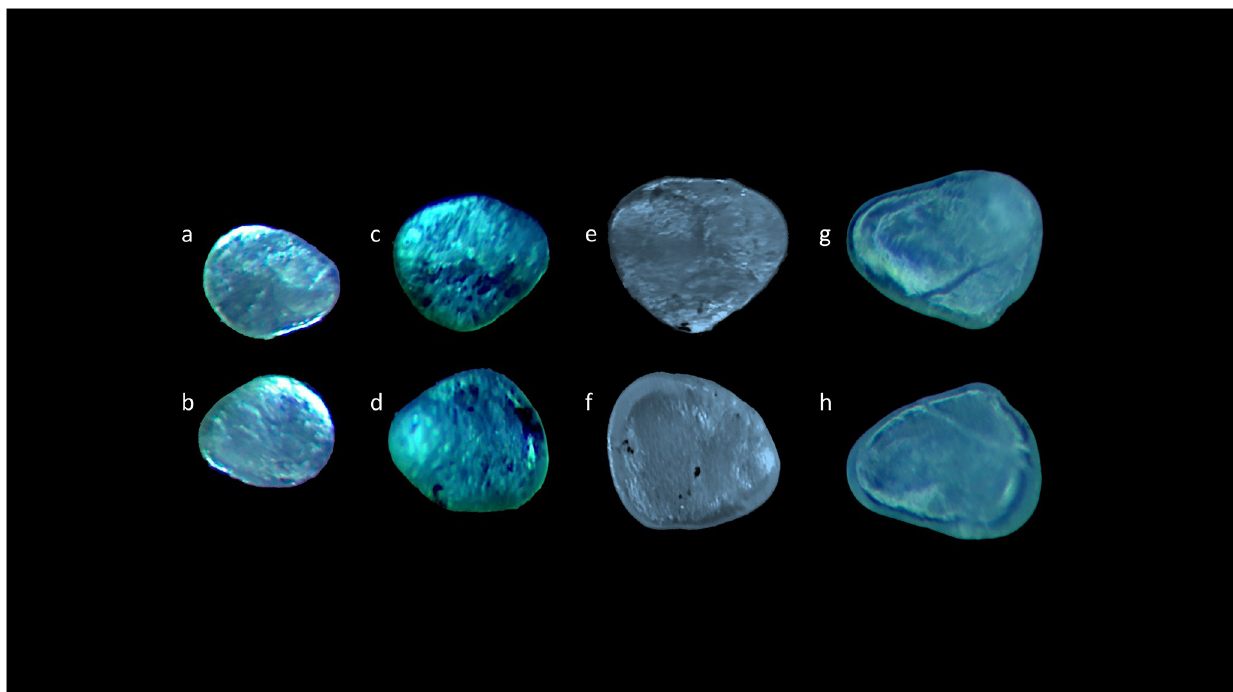
Fig 6. Stereoscope images of left (a,c,e,g) and right (b,d,,f,h) lapilli dorsal surfaces belonging to size Classes I (a,b), II (c,d), III (e,f) and IV